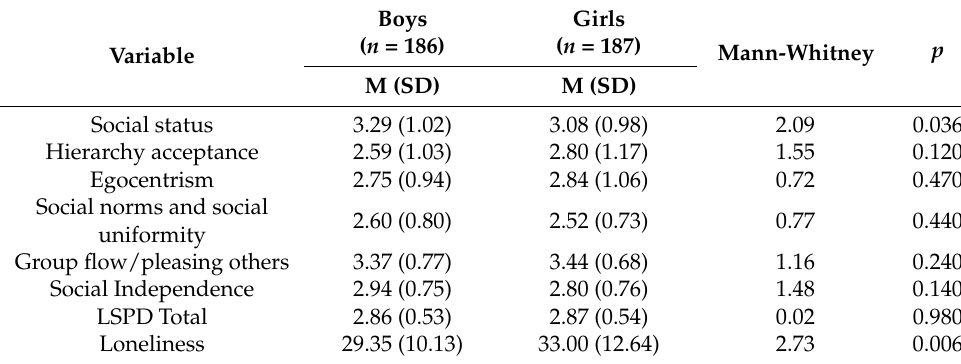
Table 4. Comparison between boys and girls in study variables.